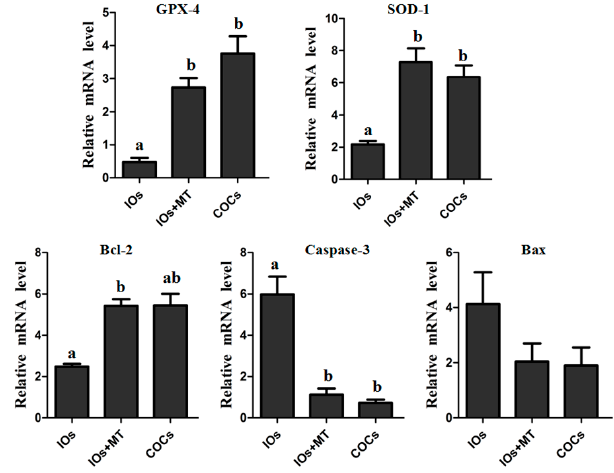
Figure 5. Relative expression levels of GPX-4 , SOD-1 , Bcl-2 , Caspase-3 and Bax in MII oocytes. a,b Values of different superscripts indicate significant difference within the expression level of each gene ( p < 0.05). COCs, cumulus-oocyte complexes; IOs, inferior bovine oocytes; MT, melatonin.